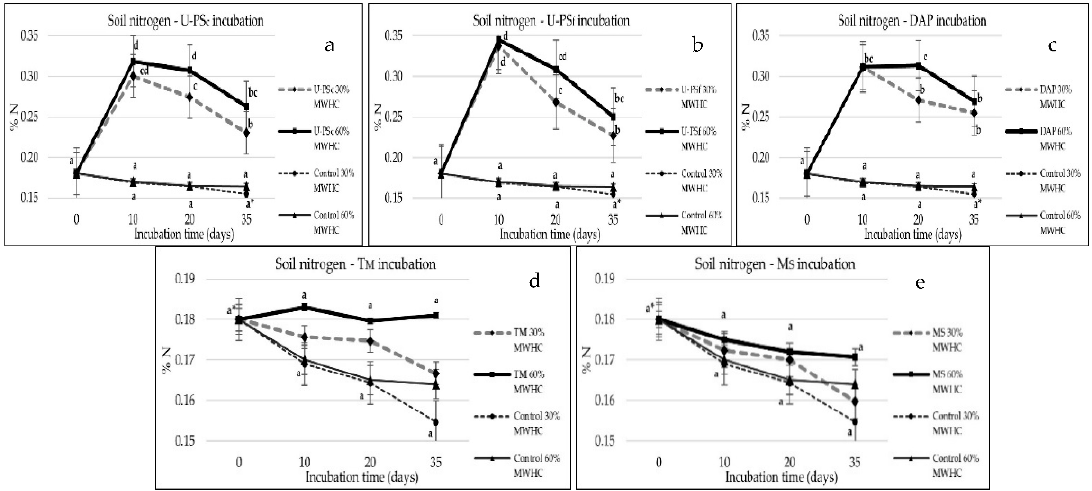
Figure 3. Effect of incubation time and soil moisture on soil nitrogen content under incubation of mineral ( a – c a; b; c; ) and organic fertilizers ( d , e ); values are mean ± standard error; * small letters indicate significant difference from one another based on Tukey’s test at p < 0.05.